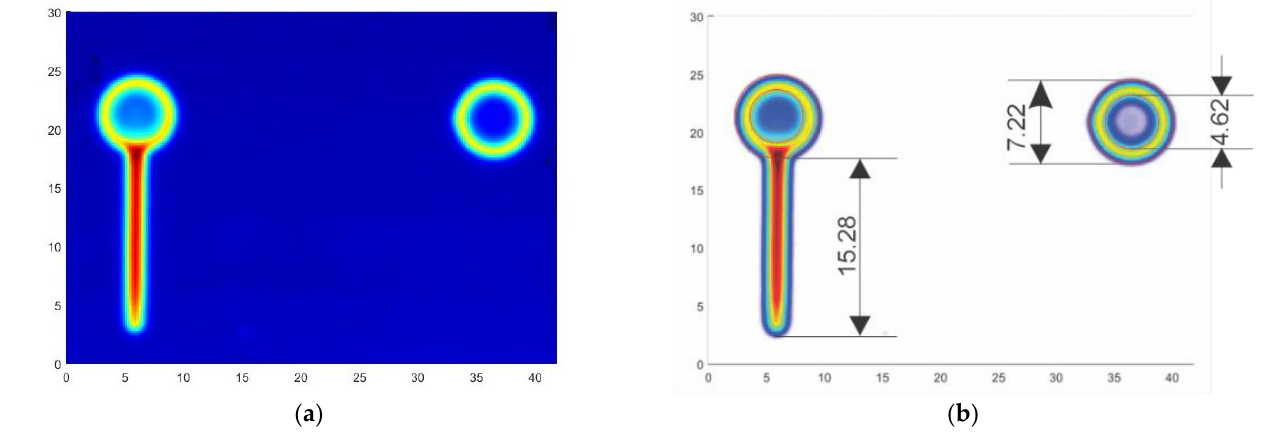
Figure 12. Estimation of crack length at the end of the fatigue test: ( a ) raw data, ( b ) processed data for crack length evaluation.